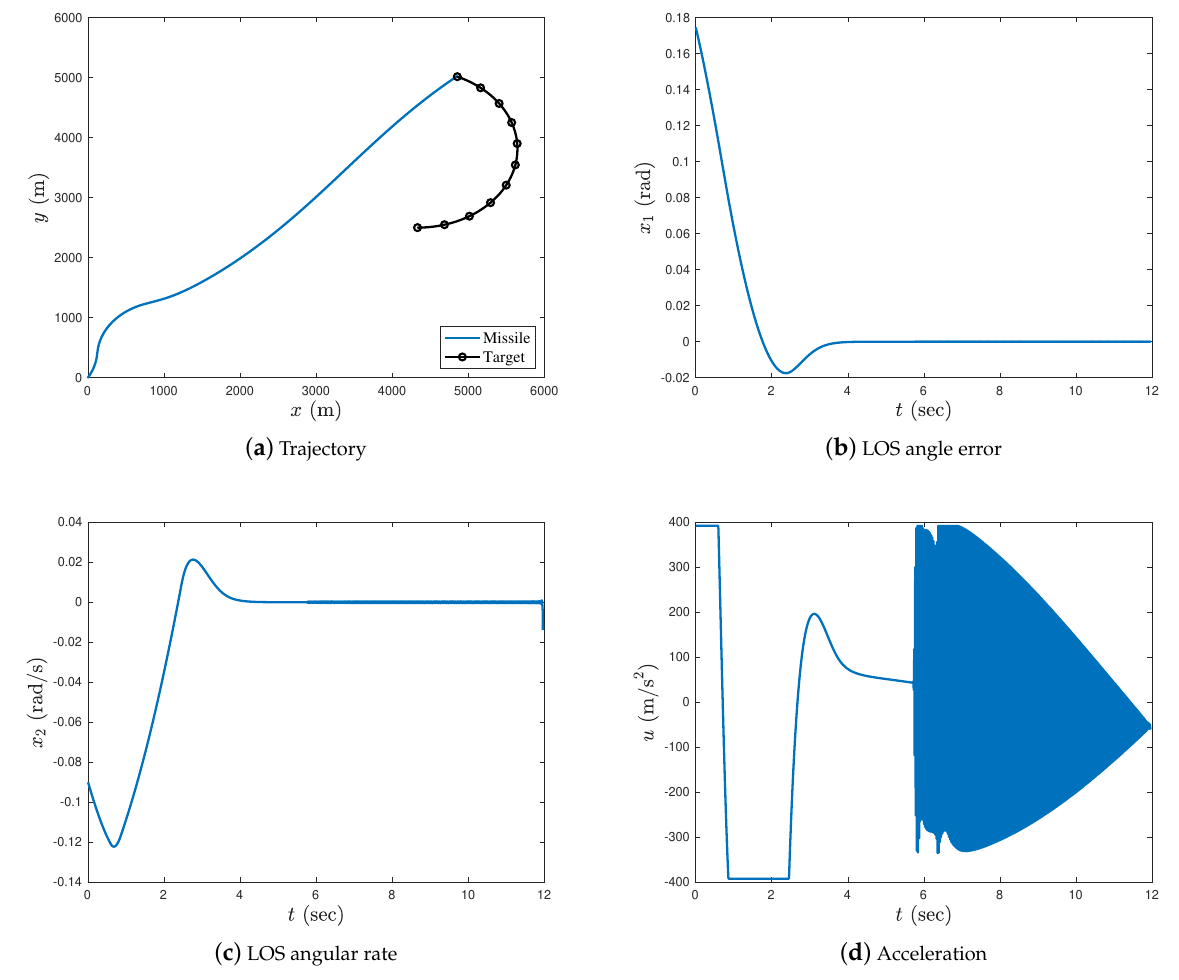
Figure 10. Simulation results with α = 0 in case 3.